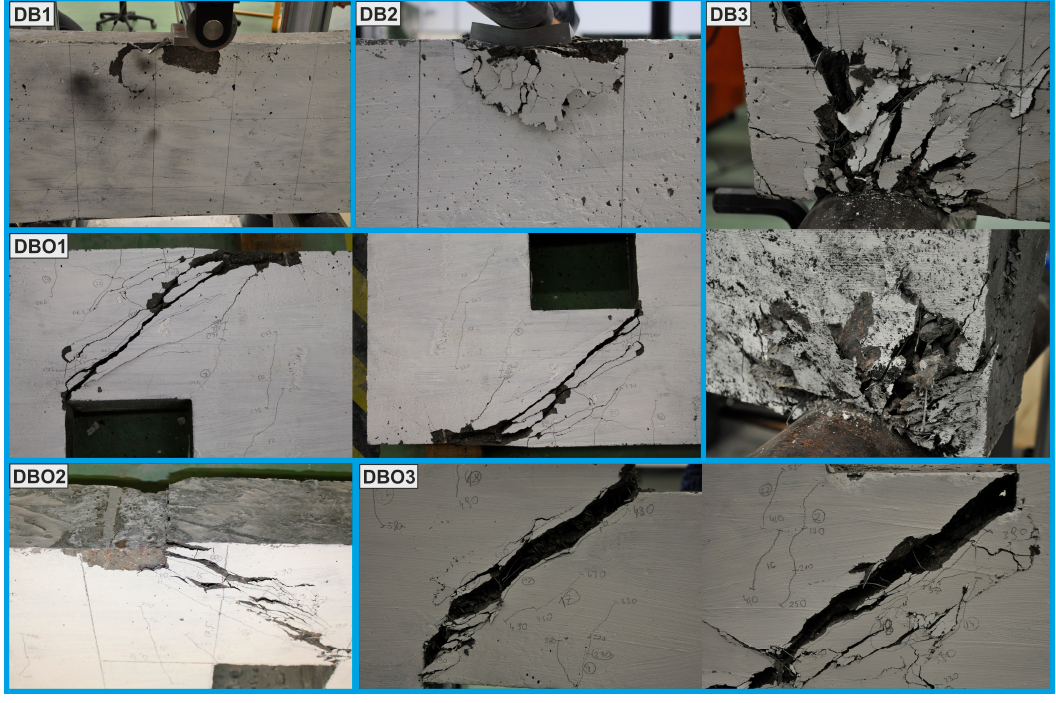
Figure 14. Failure modes of deep beams.